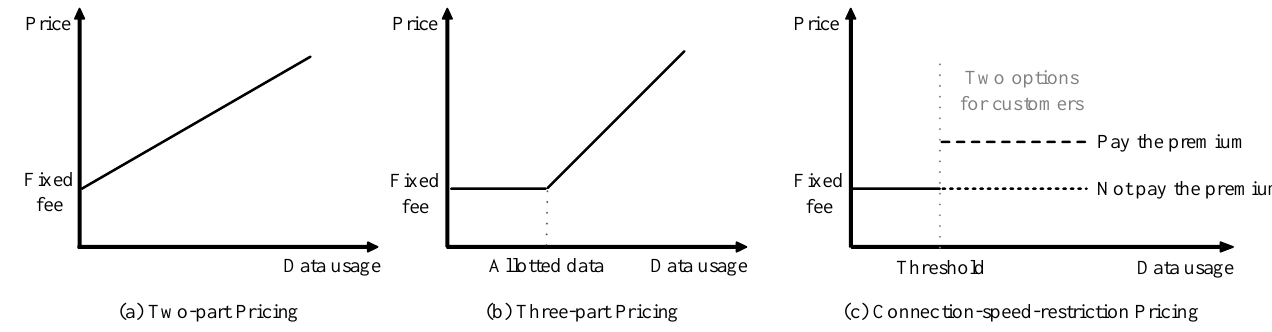
Figure 1. Two part pricing, three part pricing, and connection-speed-restriction